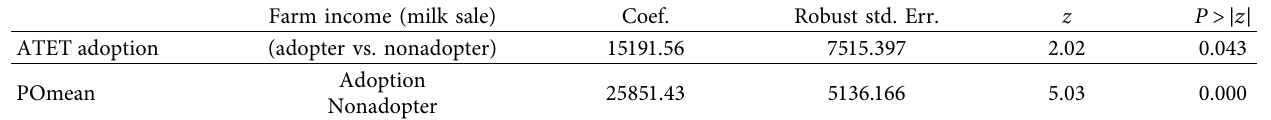
Table 12: Estimation of regression adjustment for farm income